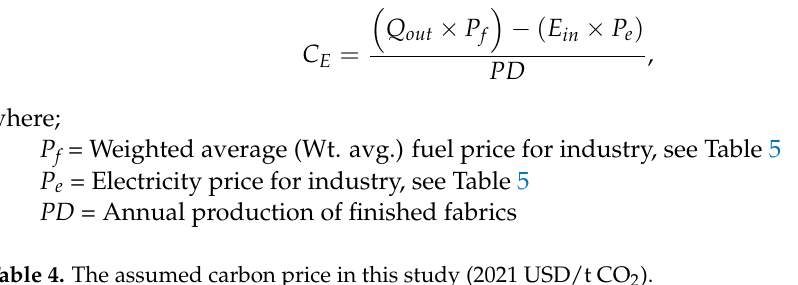
Table 4. The assumed carbon price in this study (2021 USD/t CO 2 ). Country